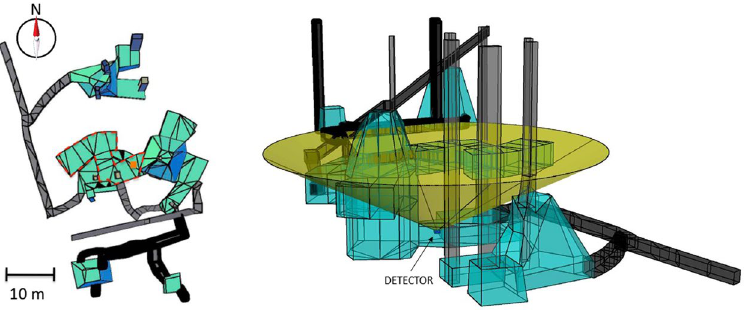
Figure 17. Left: top view of the known structures in the neighbourhood of the detector. The orange box shows the detector position, below the room indicated by the dashed line. Right: 3D view. The cone, with ∼ 120° of aperture, represents the angular acceptance of the detector. The drawings were obtained using the software Autodesk AutoCAD